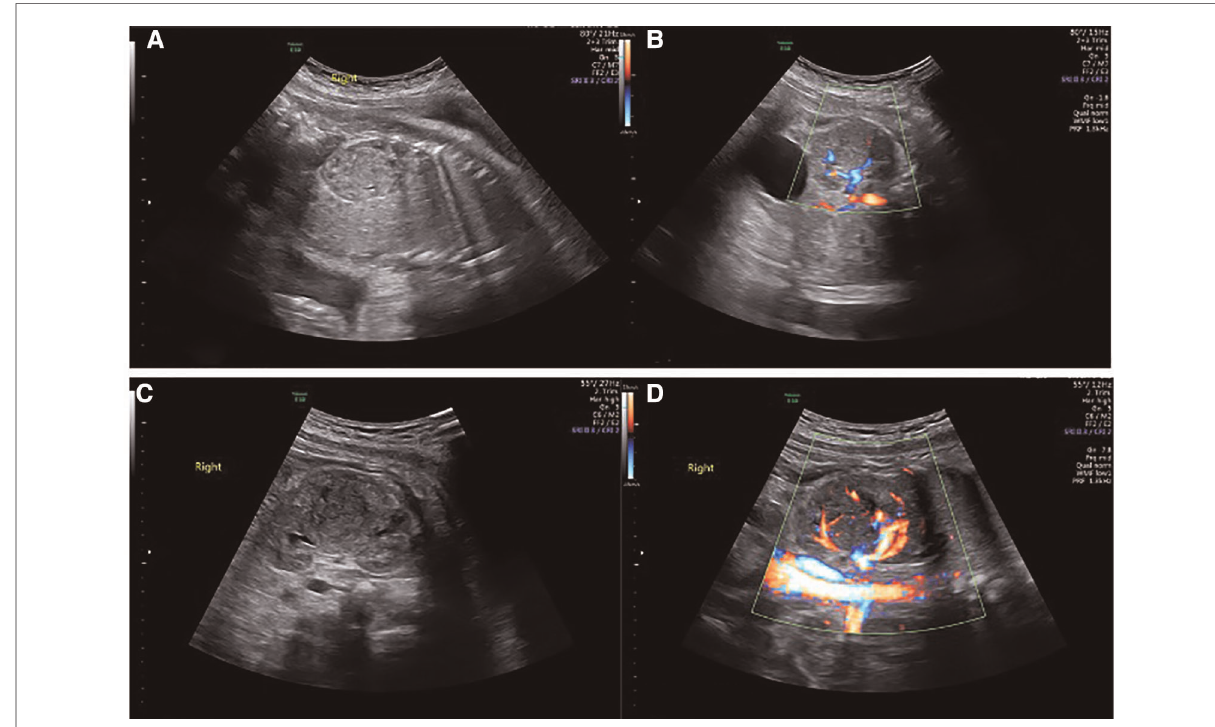
FIGURE 1 Renal solid mass at different gestational weeks. ( A,B ) showed the mass at 33 weeks and gestation by 2D and Colour Doppler. ( C,D ) showed the mass at 36 weeks of gestation by 2D and Colour